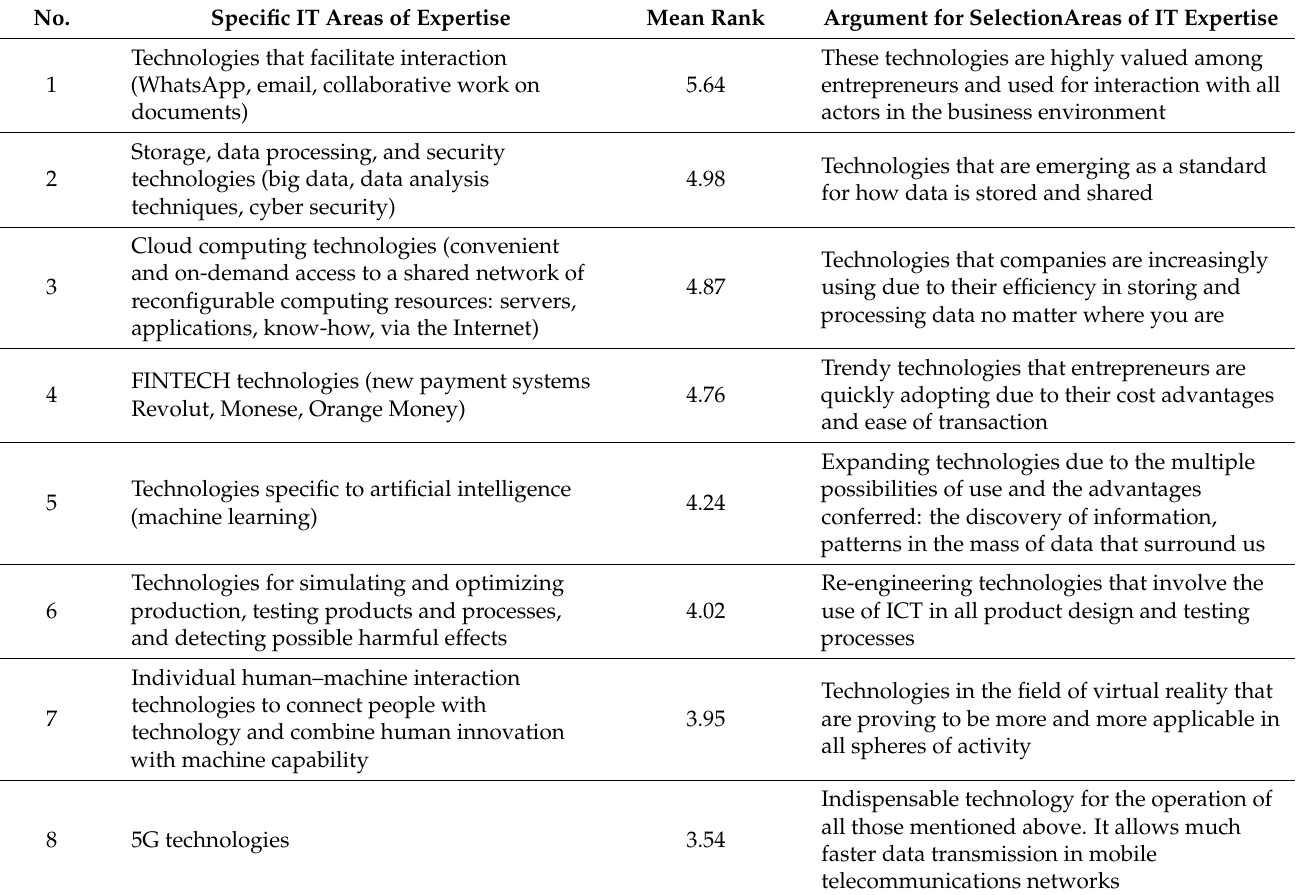
Table 17. Hierarchy of specific areas of competence in IT—Friedman